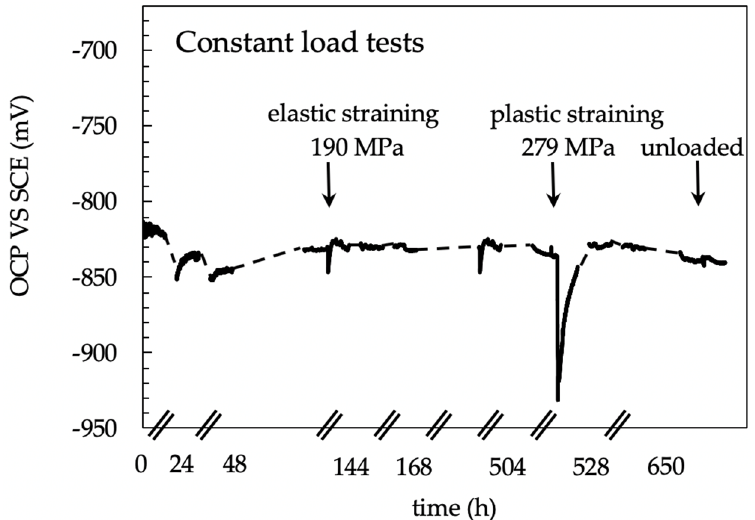
Figure 10. Open circuit potential measurements of the specimen loaded at different values during CL test. The decrease in the OCP mainly occurs as loading increase due to aluminum corrosion products cracking.